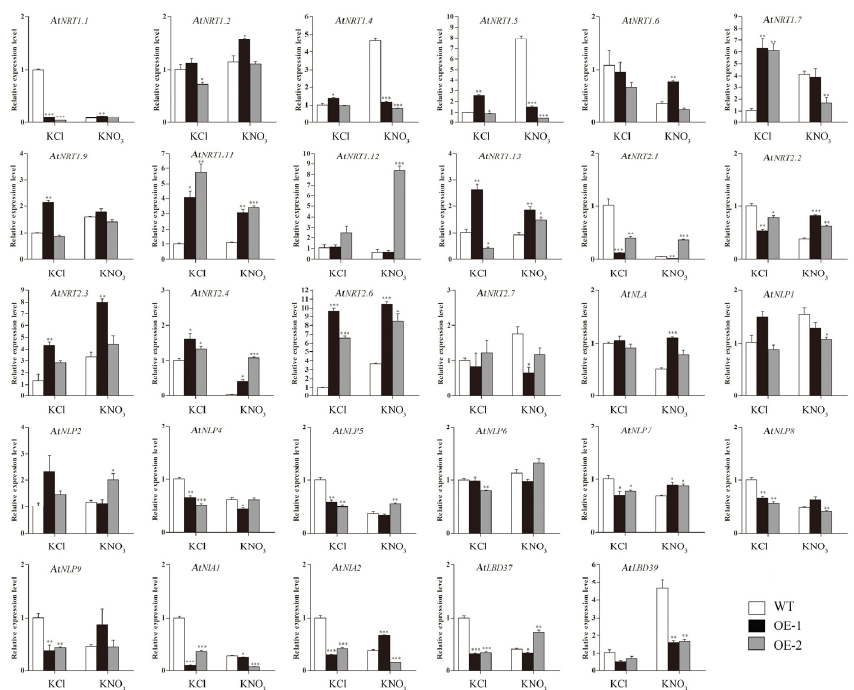
Figure 14. The expression levels of nitrate response related genes in roots of WT and transgenic Arabidopsis plants hosting CsLBD39 gene under KCl and KNO 3 conditions. The data are expressed as mean ± standard deviation of three biological replicates ( n = 3). Asterisks (*) indicate that the value is significant difference compared to the WT (* p < 0.05; ** p < 0.01; *** p < 0.001).